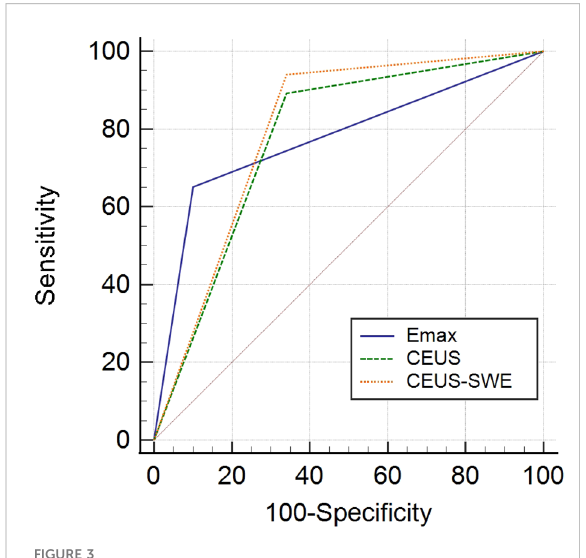
FIGURE 3 ROC of contrast-enhanced ultrasound (CEUS), shear wave elastography (SWE), and the combination of CEUS and SWE in differentiating benign and malignant nodules. ROC, receiver operating characteristic; AUC, area under the ROC